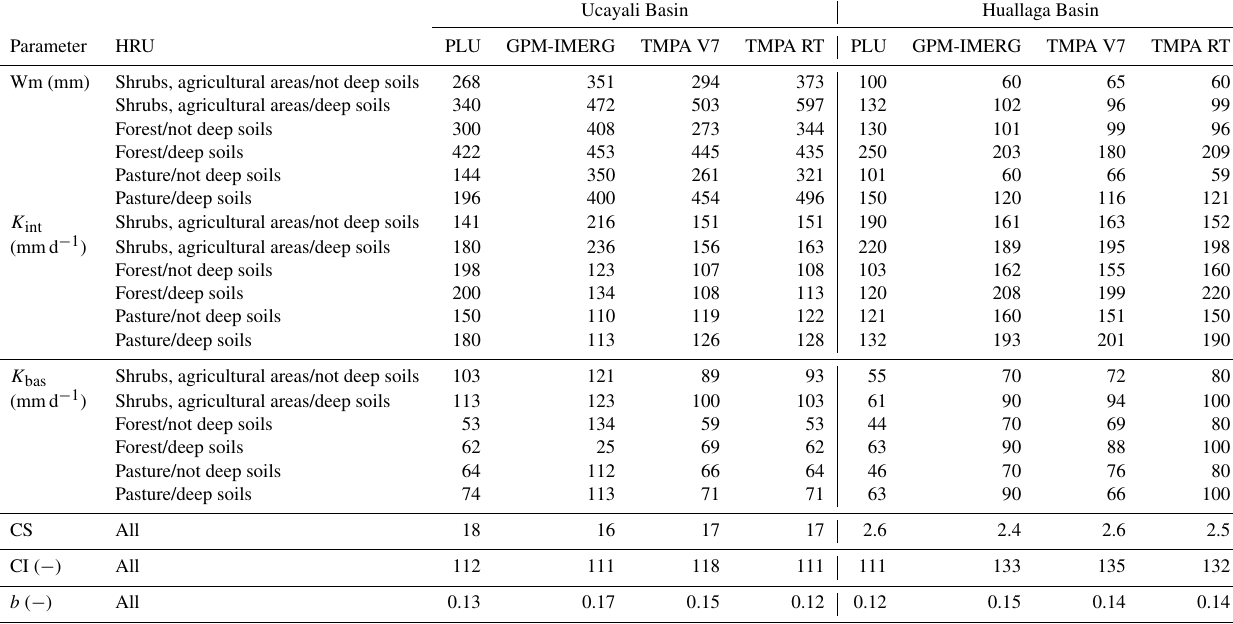
Table 4. Values of the model mean parameters used in the Ucayali and Huallaga basins for each rainfall datasets for the 2014–2015 period. Ucayali Basin